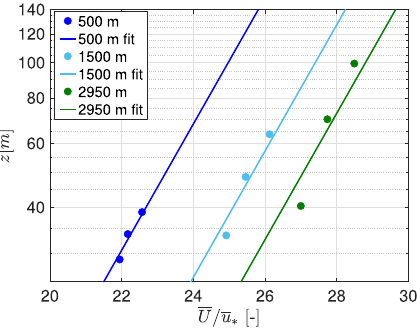
Figure 10. Comparison of the PPI observations with Eqs. (1) and (3) using the α c dependency on distance to the coast at posi- tions 500, 1500 and 2950m from the